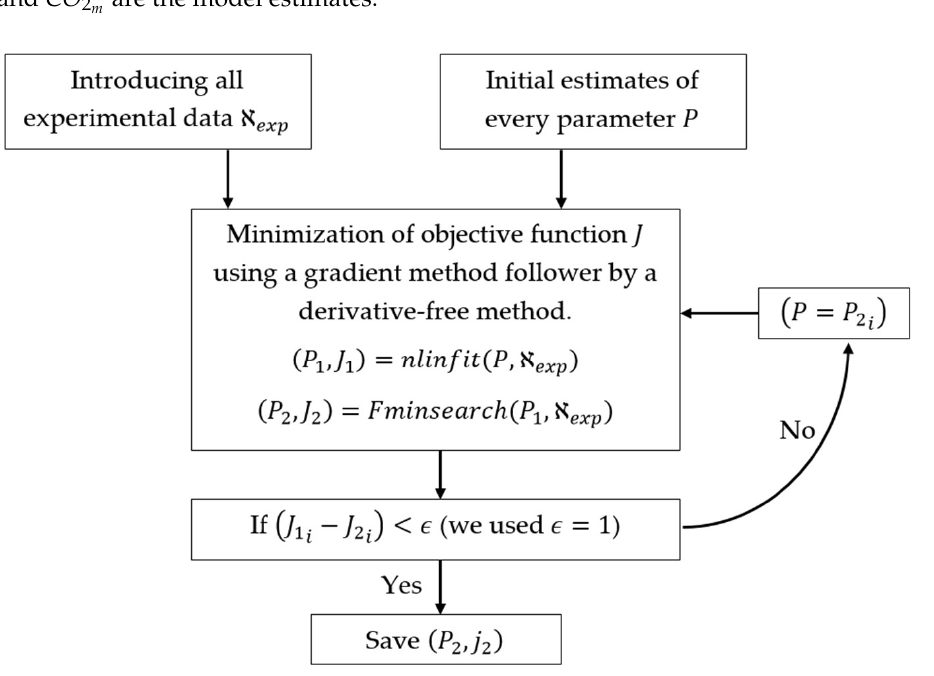
Figure 4. In the algorithm used for kinetic fitting, the subscript i refers to the value of the functions J and P at the iteration i −